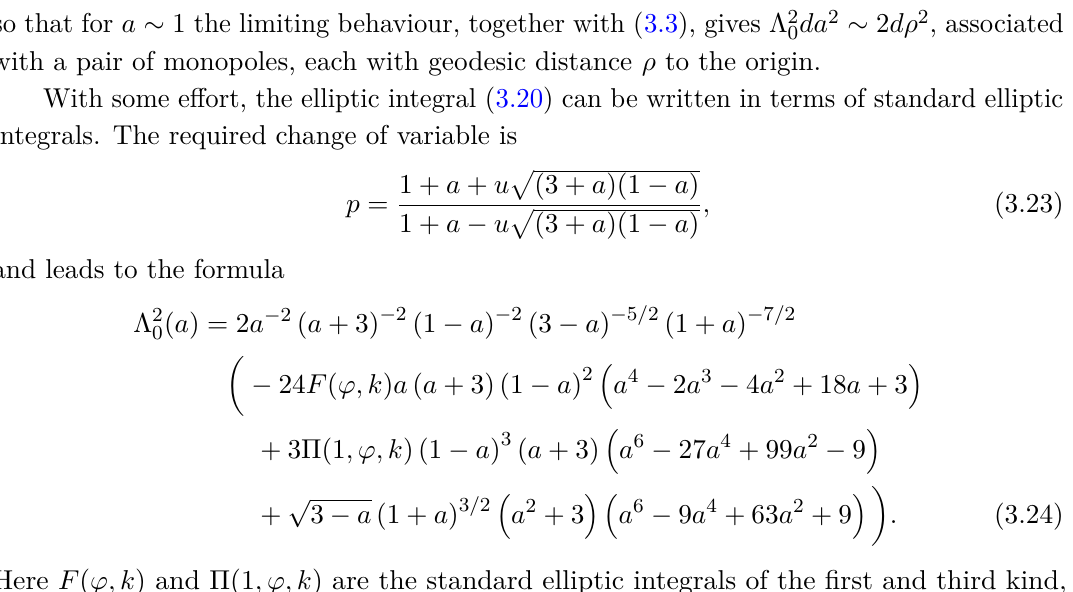
da 2 ∼ 2 dρ 2 , associated 0